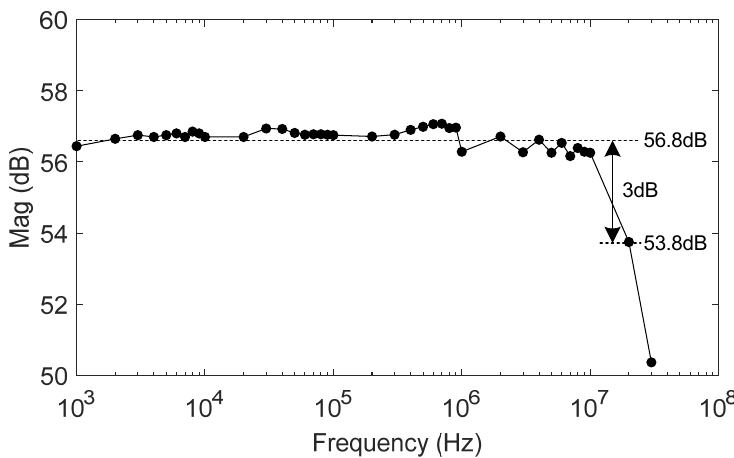
Figure 20. Experimental results of SNR variation with frequency of a sinusoidal input signal.